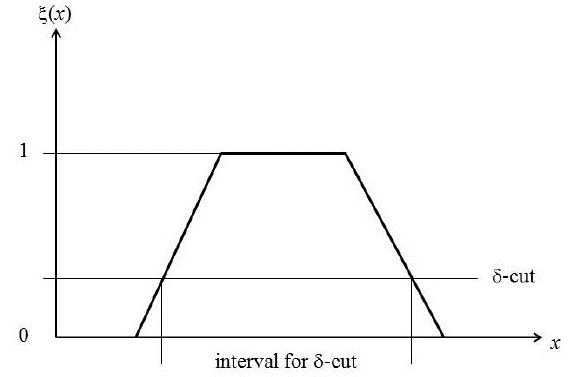
Figure 1. Fuzzy number and 